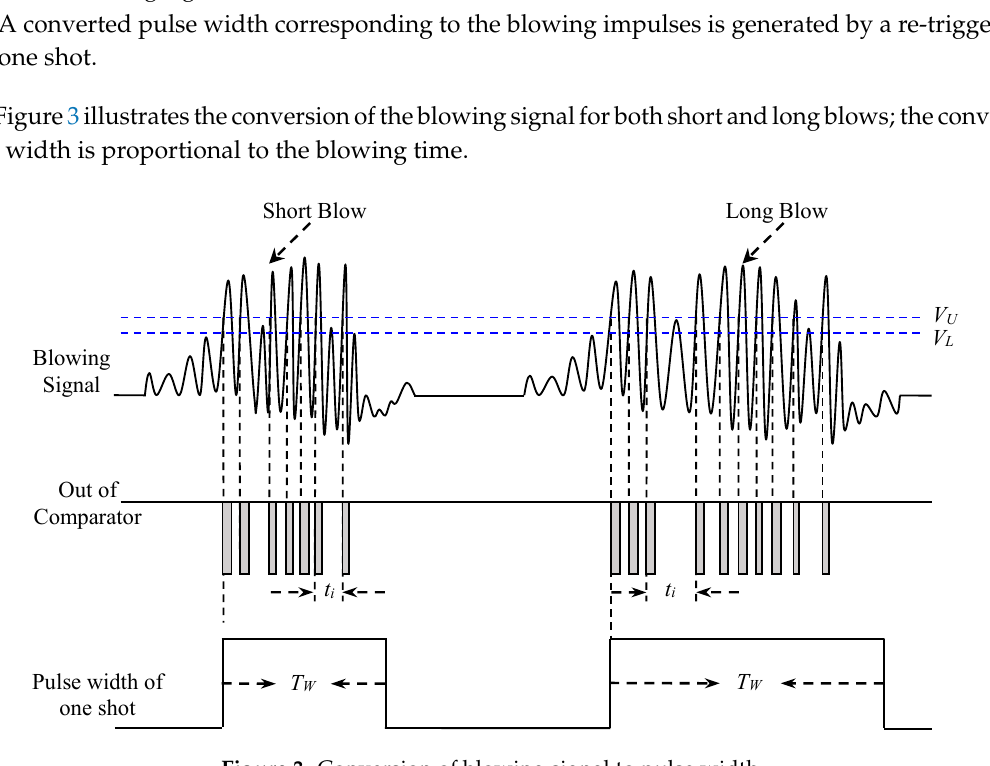
Figure 3. Conversion of blowing signal to pulse width.